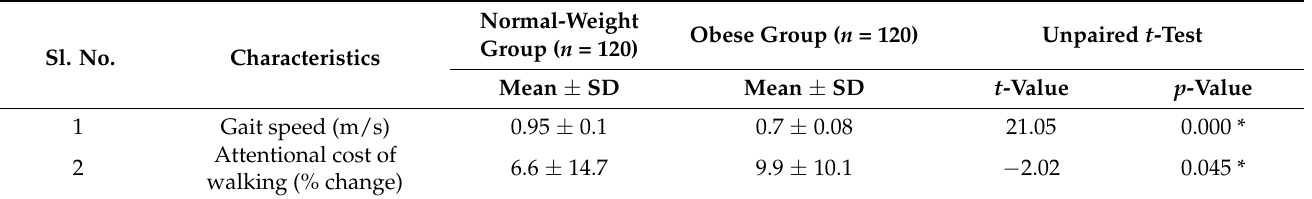
Table 1. Attentional cost on gait speed under a sensory-motor dual-task condition among normal- weight and obese college-going populations.